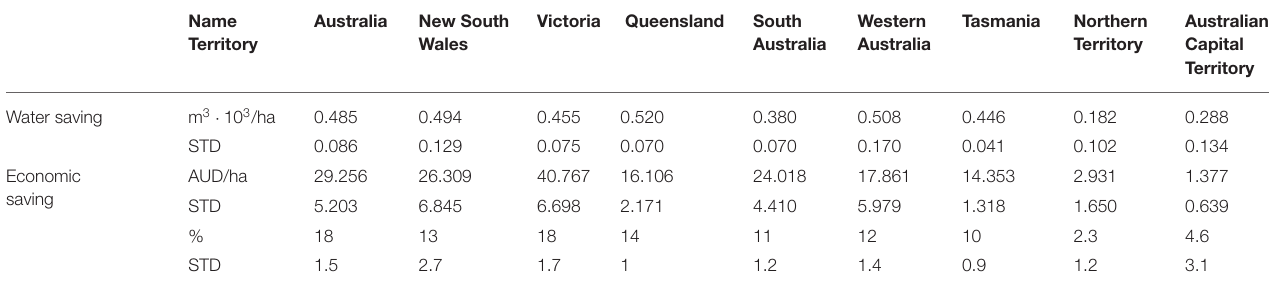
TABLE 7 | Water Saving and Economic Saving when irrigation efficiency rises up of 25% (scenario B).